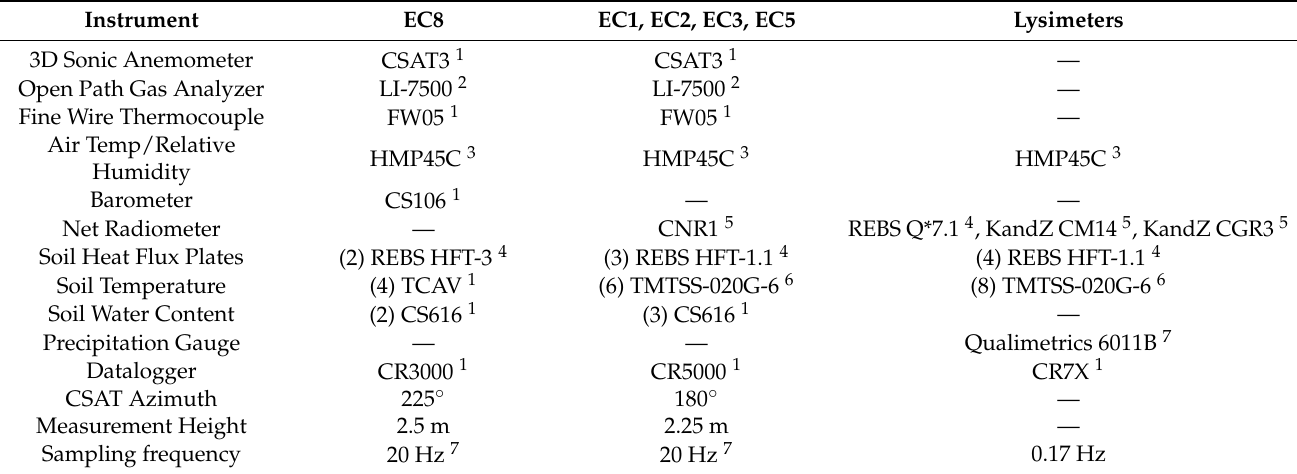
Table 1. Instrumentation details for the eddy covariance systems and